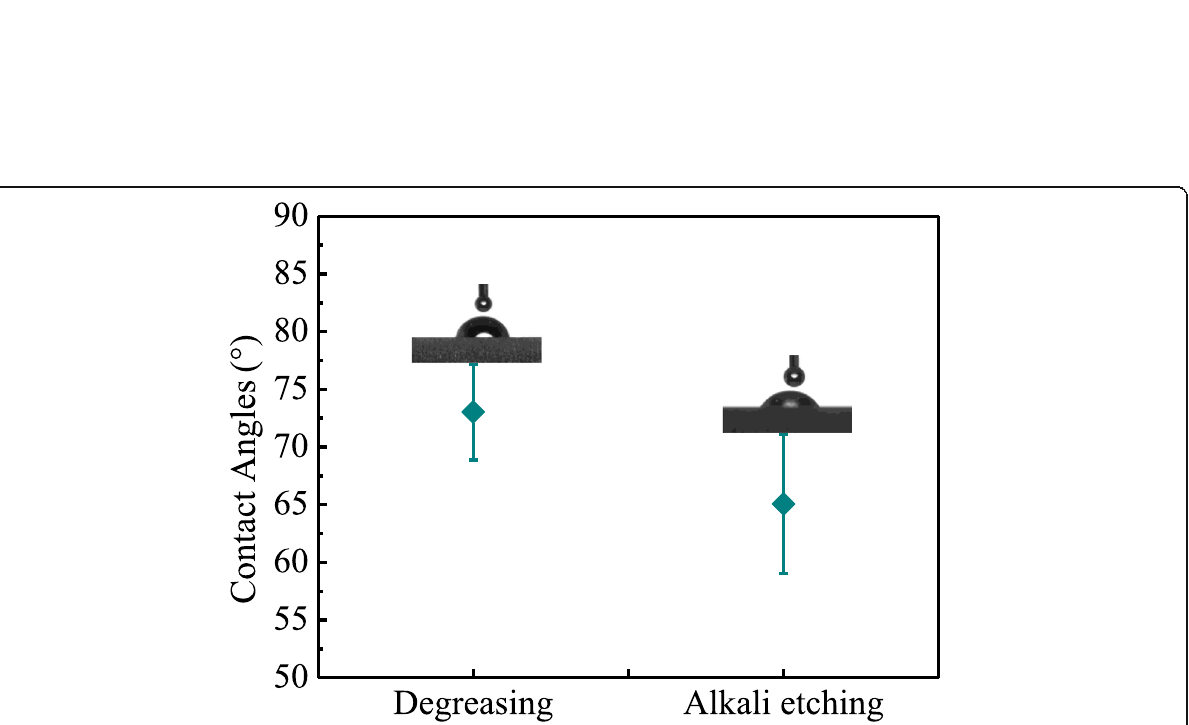
Fig. 7 Contact angle of water droplet on the Al alloy surface with different surface